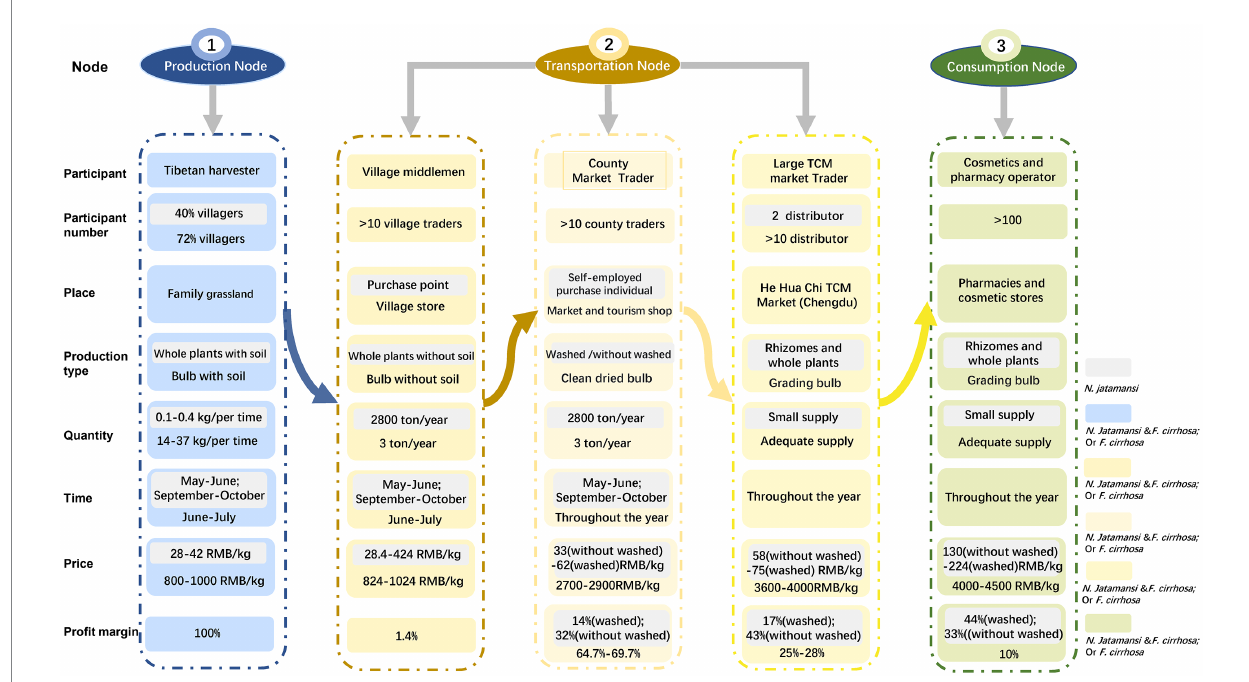
FIGURE 4 The trade and value chain of N. jatamansi and F. cirrhosa . The price is dry weight price; and the profit does not include labor cost and other material cost. Production node data is from the pilot interview ( N = 37) and harvester survey ( N = 923). The data of rural and county sections in transportation node are from trader interview ( N = 20) and investigation on Hehuachi TCM Market in Chengdu. Consumption node data is from online shopping platform “Taobao.” Refer to the text (Result 4.2 the Trade of N. jatamansi and F. cirrhosa ) for more details.